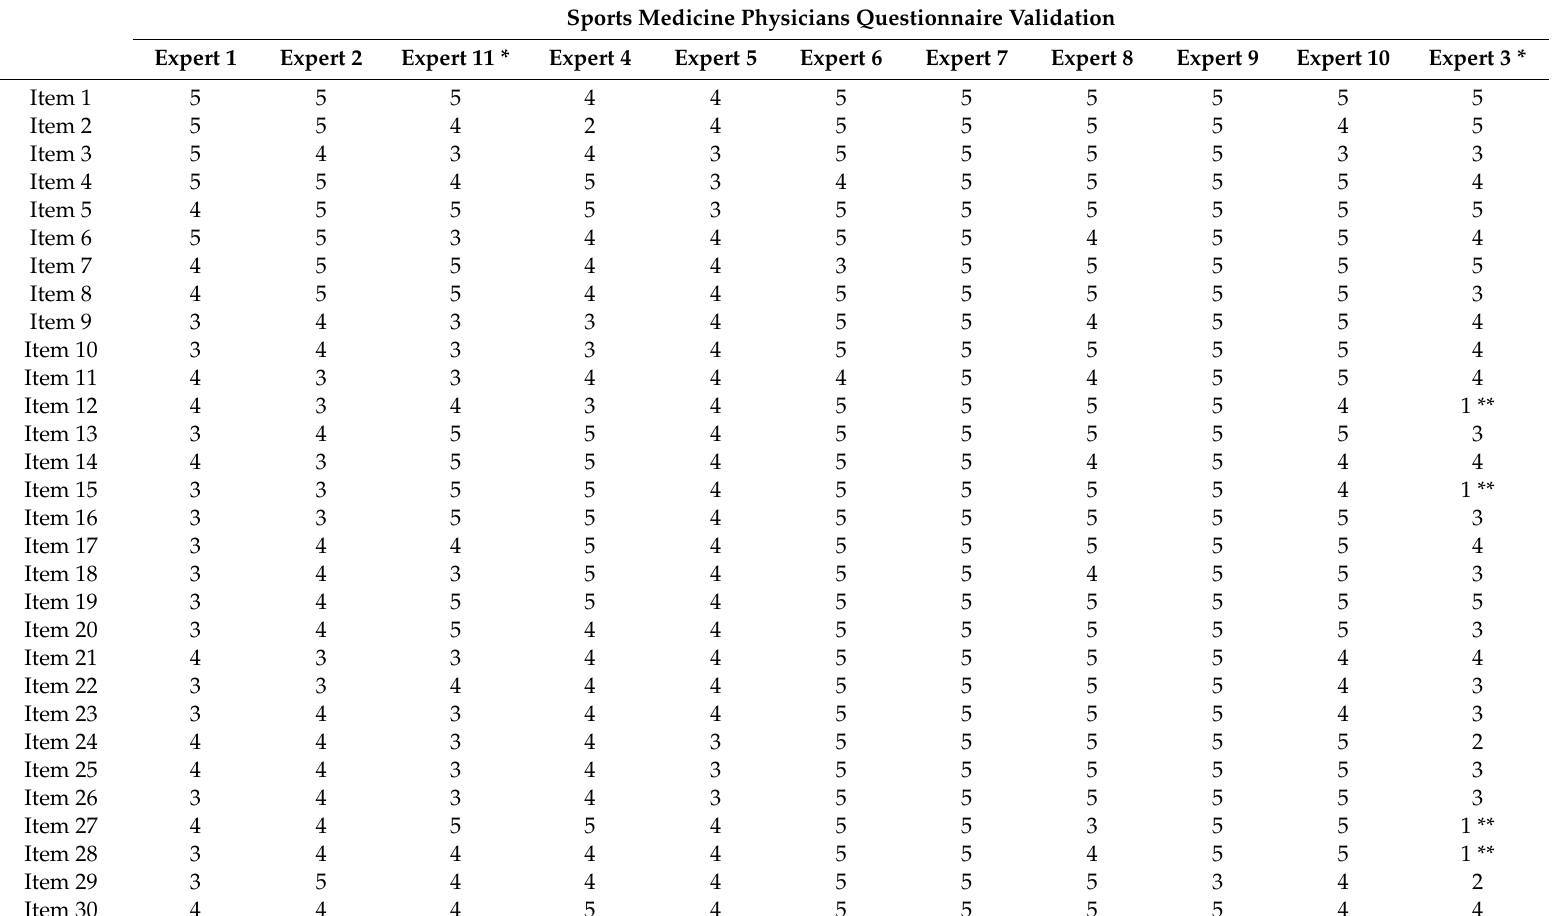
Table 4. Values o ff ered by the sports medicine physicians’ experts in all questionnaire items for the